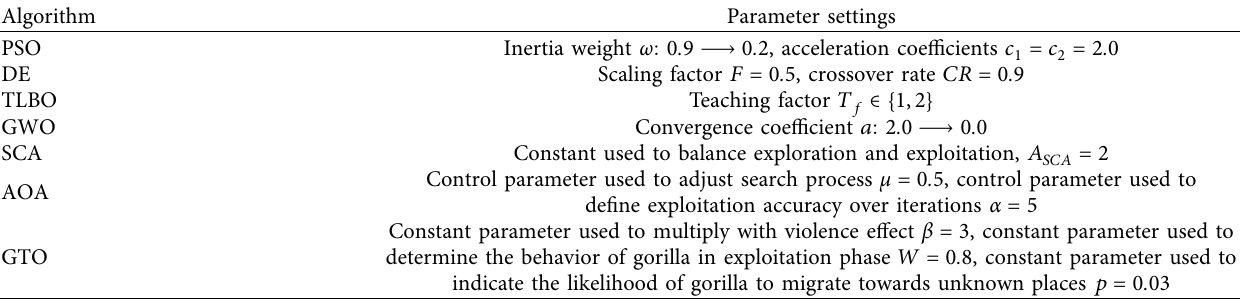
Table 8: Parameter settings of all compared metaheuristic search algorithms used to solve WEDM machining optimization problems. Algorithm Parameter settings